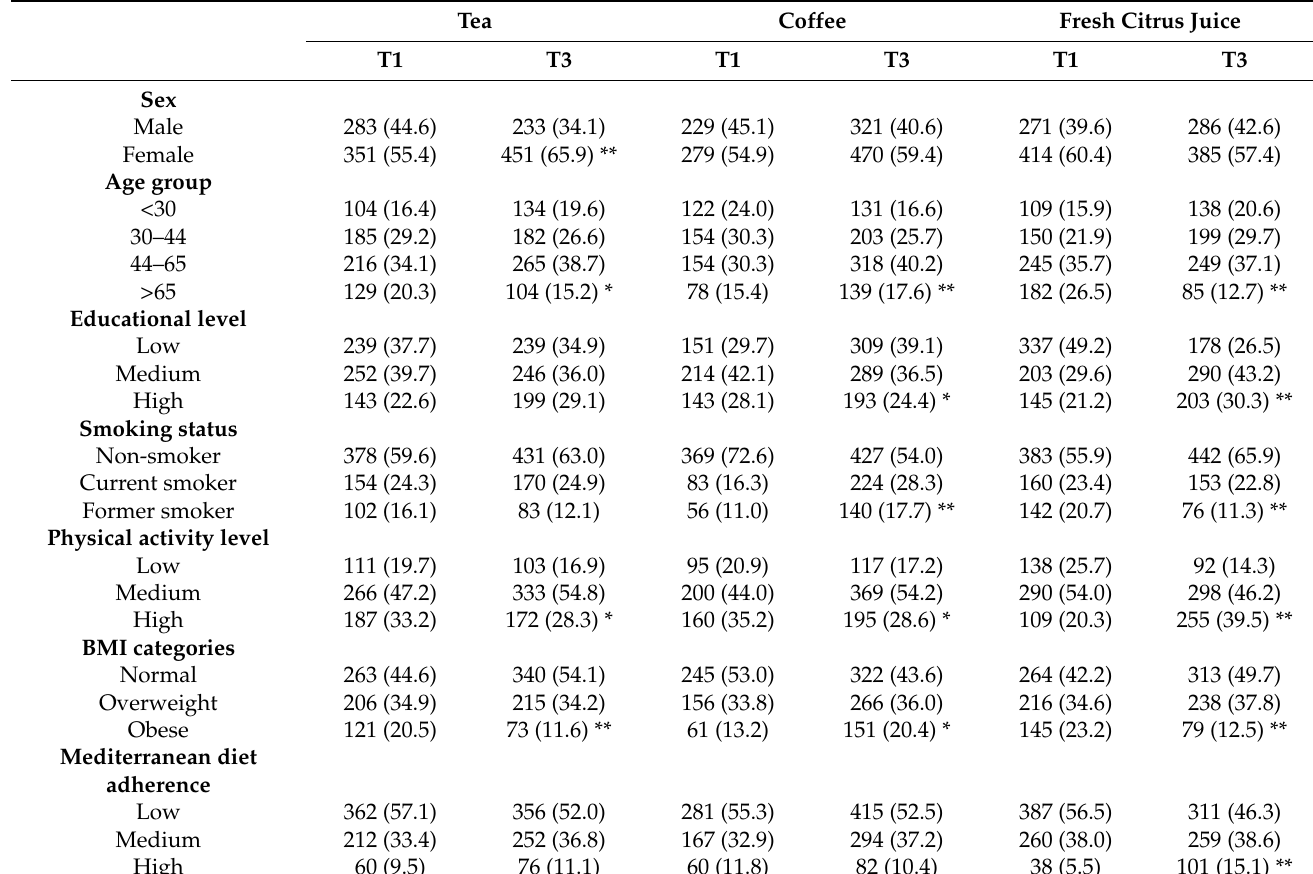
Table 1. Background characteristics of the study sample by consumption of individual polyphenol-rich